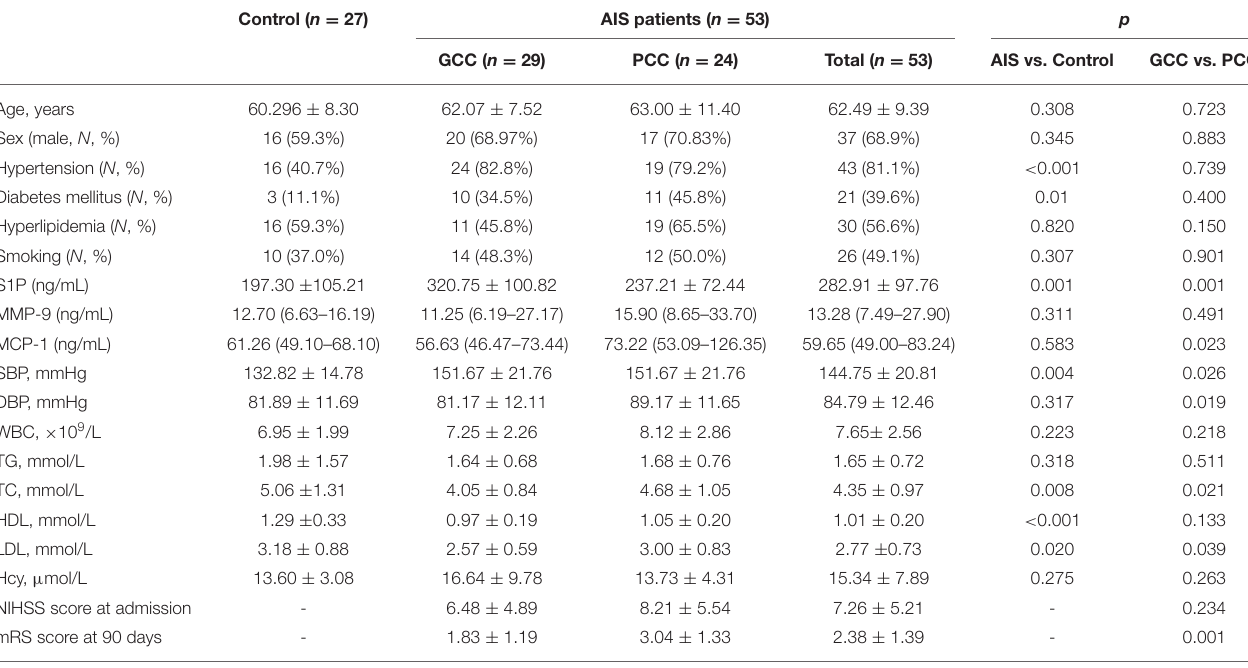
TABLE 2 | General characteristics of control and patients with AIS in the validation stage. Control ( n =